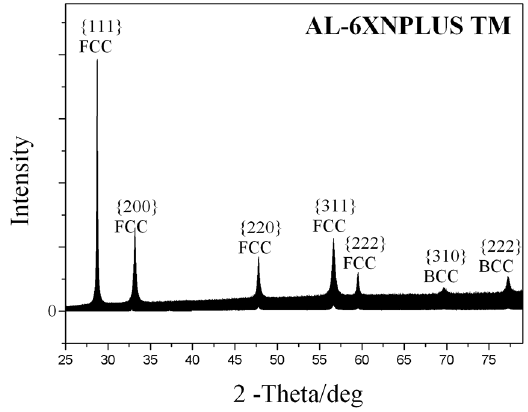
Figure 6. XRD pattern for the AL-6XNPLUS™ steel in the as received condition (synchrotron light radiation source, λ = 0.10332